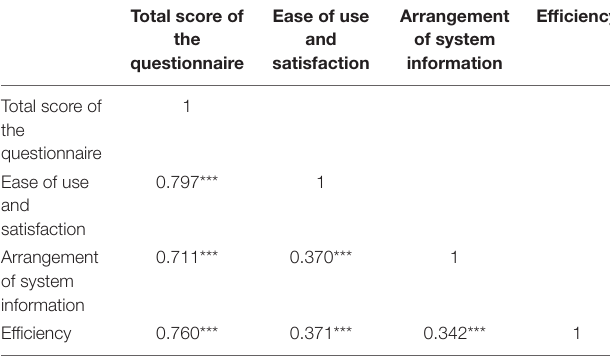
TABLE 5 | The correlation analysis of three dimensions using the Pearson’s correlation